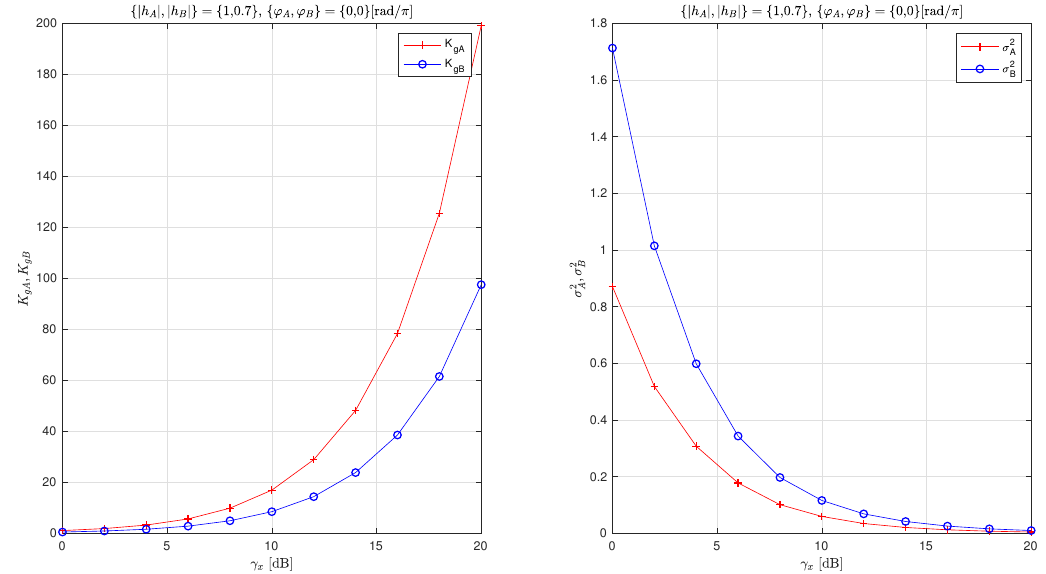
Figure 7. Equivalent detector gain and equivalent noise variance as a function of